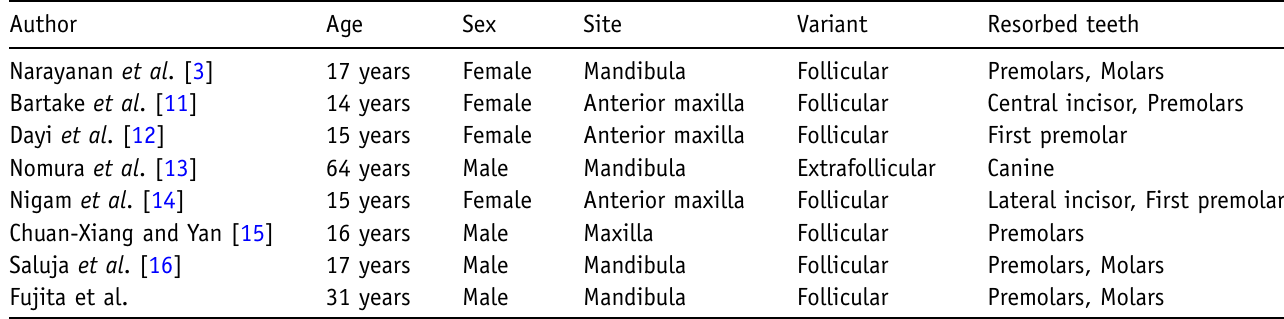
Table I. Seven cases of AOT with root